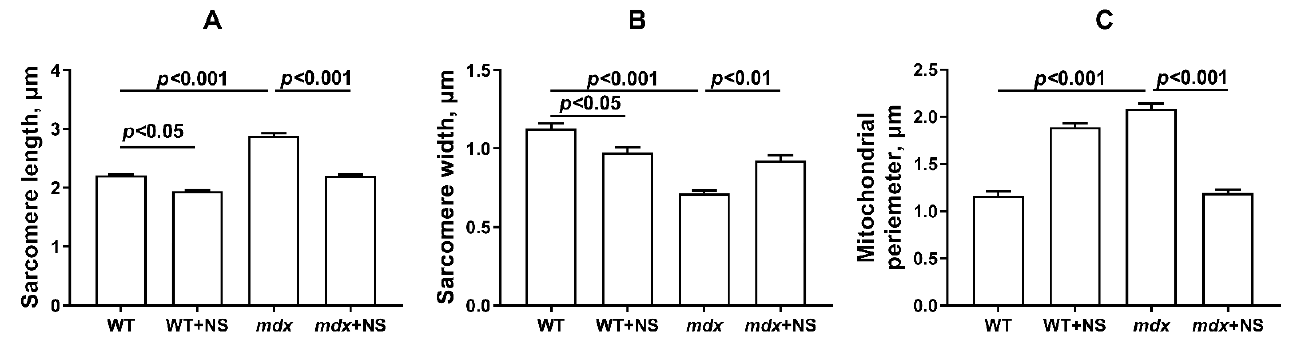
Figure 6. Graphical representation of electron micrograph (Figure 5) profiles: sarcomere length ( A ), sarcomere width ( B ), and mitochondrial perimeter ( C ). The number of examined fields of view varied from 40 to 50. The data are presented as m ± SEM.